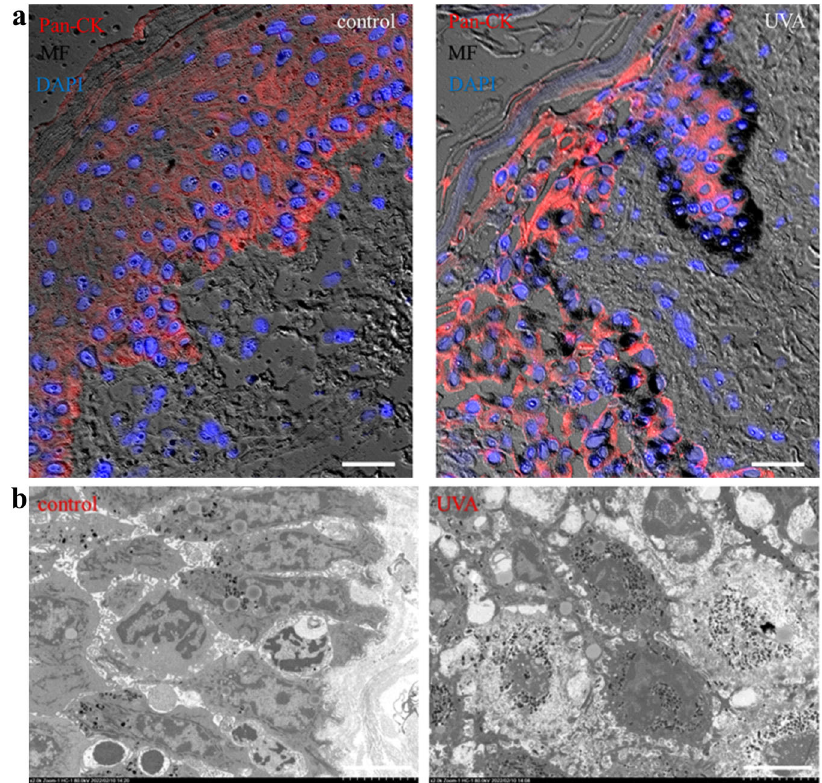
Fig. 1 UVA induces melanin cap formation in keratinocytes. a Masson-Fontana (MF) staining showed melanin cap localization in skin explants after 48 h of UVA irradiation (control group (left), UVA-treatment group (right)). Pan-Cytokeratin (Pan-CK) (red) is a marker of keratinocytes. Nuclei were counterstained with 4 ′ ,6-diamidino-2-phenylindole (DAPI)(blue). Images were fi xed and analyzed by bright fi eld/ fl uorescence microscopy. Scale bar = 20 µ m. b Melanin cap was observed by transmission electron microscopy. Scale bar = 5 μ